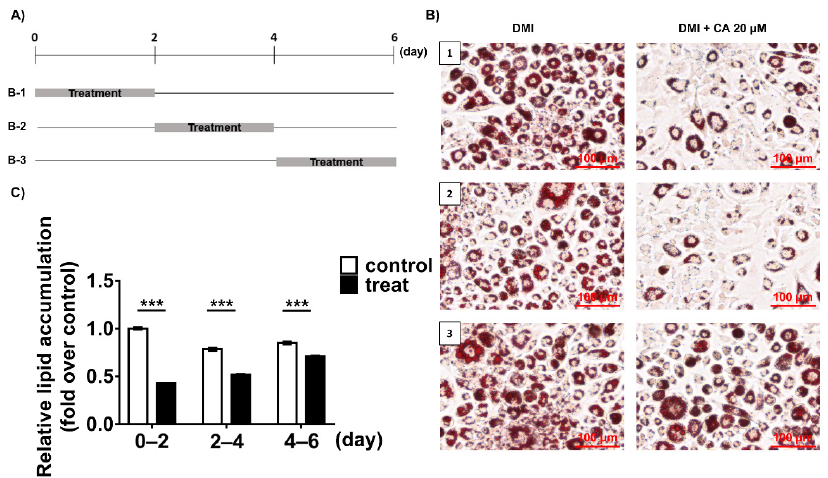
Figure 5. Effects of chebulinic acid (CA) on dexamethasone, methylisobutylxanthine, and insulin (DMI)-induced differentiation of 3T3-L1 preadipocytes in different stages of cells. ( A ) The schedule for chebulinic acid treatment during the differentiation of 3T3-L1 preadipocytes to adipocytes. Cells were treated with chebulinic acid (20 µ M) on day 0–2 (B-1), day 2–4 (B-2), or day 4–6 (B-3) during differentiation by DMI treatment; ( B ) representative images of oil red O-stained cells. Each number on the picture corresponds to the number listed vertically (B-1, B-2, B-3) in Figure 5A. Scale bar: 100 µ m; ( C ) after the extraction of oil red O from the stained cells, their absorbance was measured at 520 nm. The results are presented as the mean ± standard deviation (SD, n = 3); *** p < 0.001 compared to the control group.